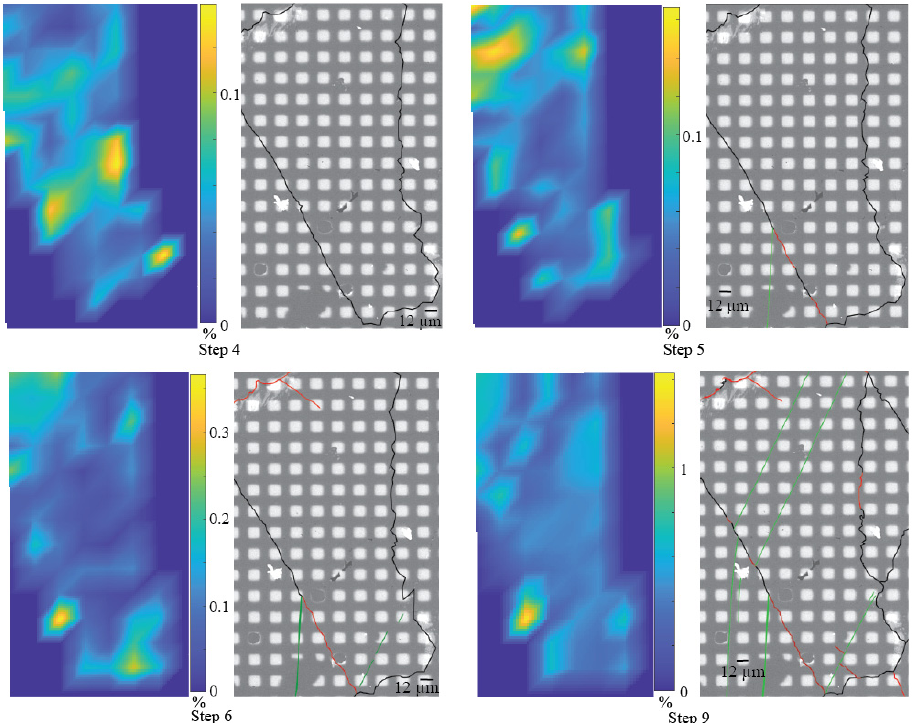
Figure 10. Equivalent Von Mises deformation map of crystal 2 at different steps of sample deformation. The black lines represent the grain boundaries. The green lines show the twinned planes. The red lines show the fracture zones.